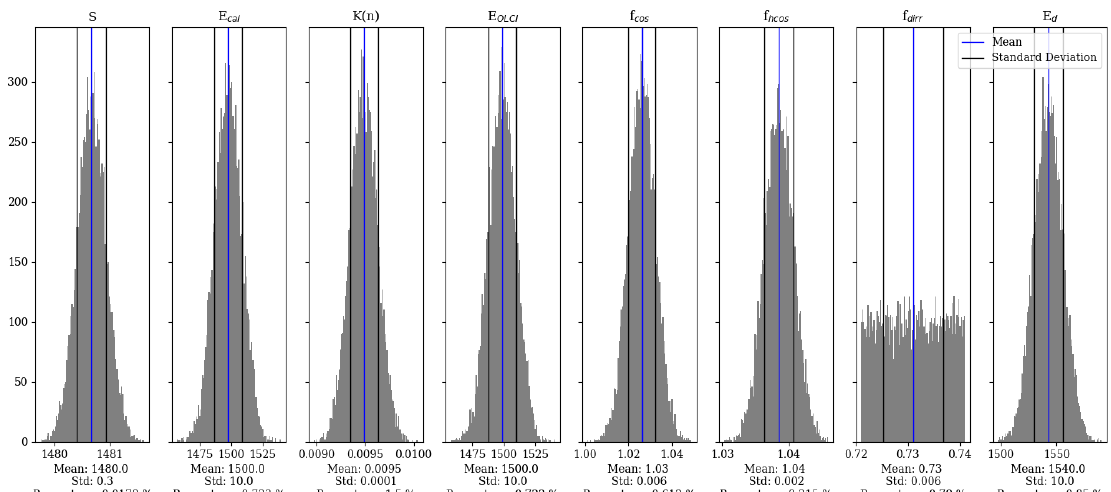
Figure 9. Histograms of several variables in the measurement process for the ideal case of cast 1, band 442.5 nm. The mean, standard deviation and standard deviation as a percentage of the mean (coefficient of variation CV) are labelled below the histograms.